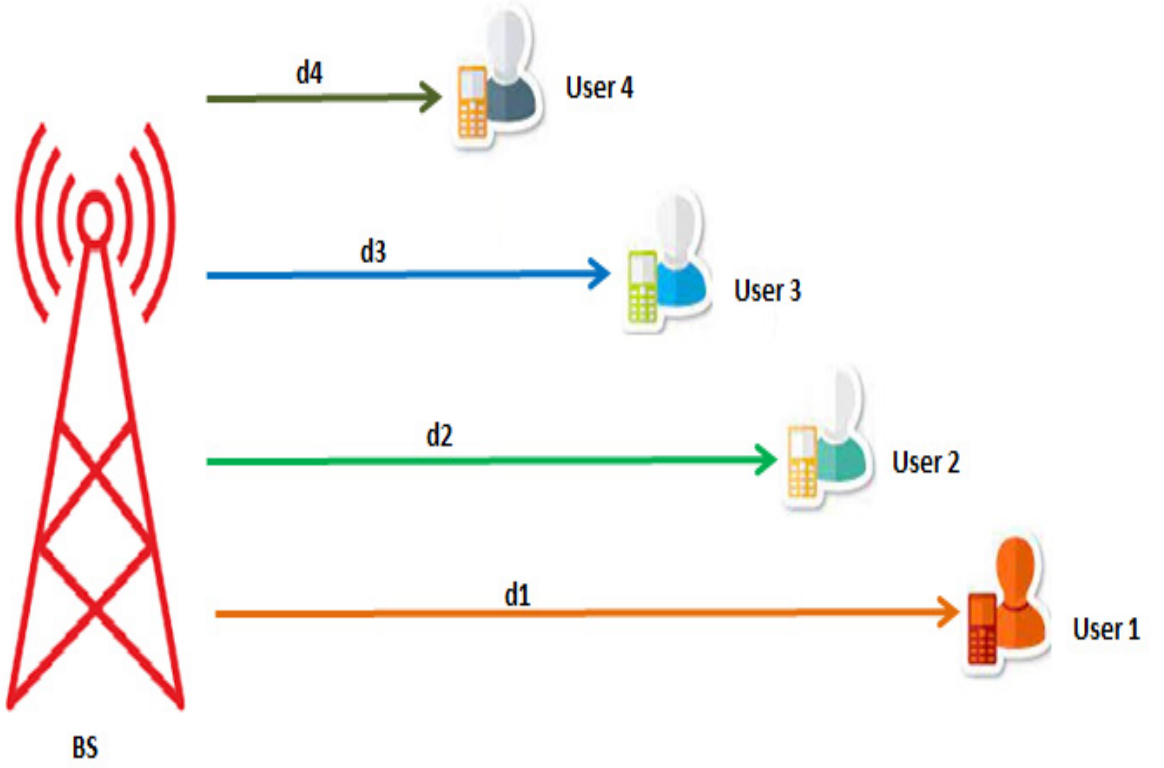
Figure 1. Depicts the wireless network with four users (DL-NOMA